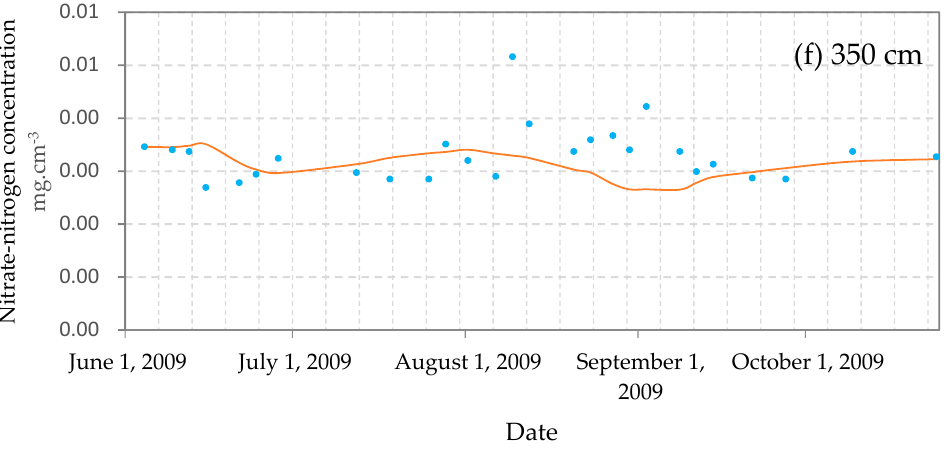
Figure 5. Measured (dots) and simulated (lines) nitrate nitrogen concentrations at depths of ( a ) 50, ( b ) 100, ( c ) 200, ( d ) 250, ( e ) 300 and ( f ) 350 cm from June to November 2009.